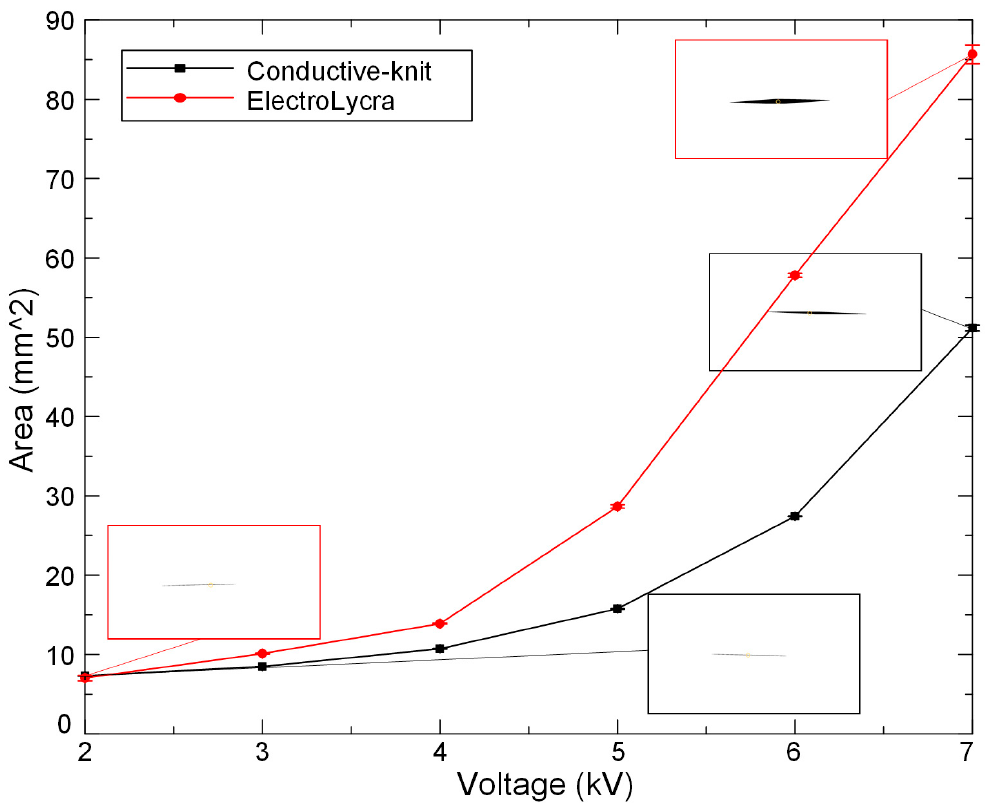
Figure 6. Breathability control comparison between the ElectroLycra and Conductive-knit textile DEAs from 2 to 7 kV. Area denotes the area of the aperture slit in the auxetic (images show slit at minimum and maximum voltages).